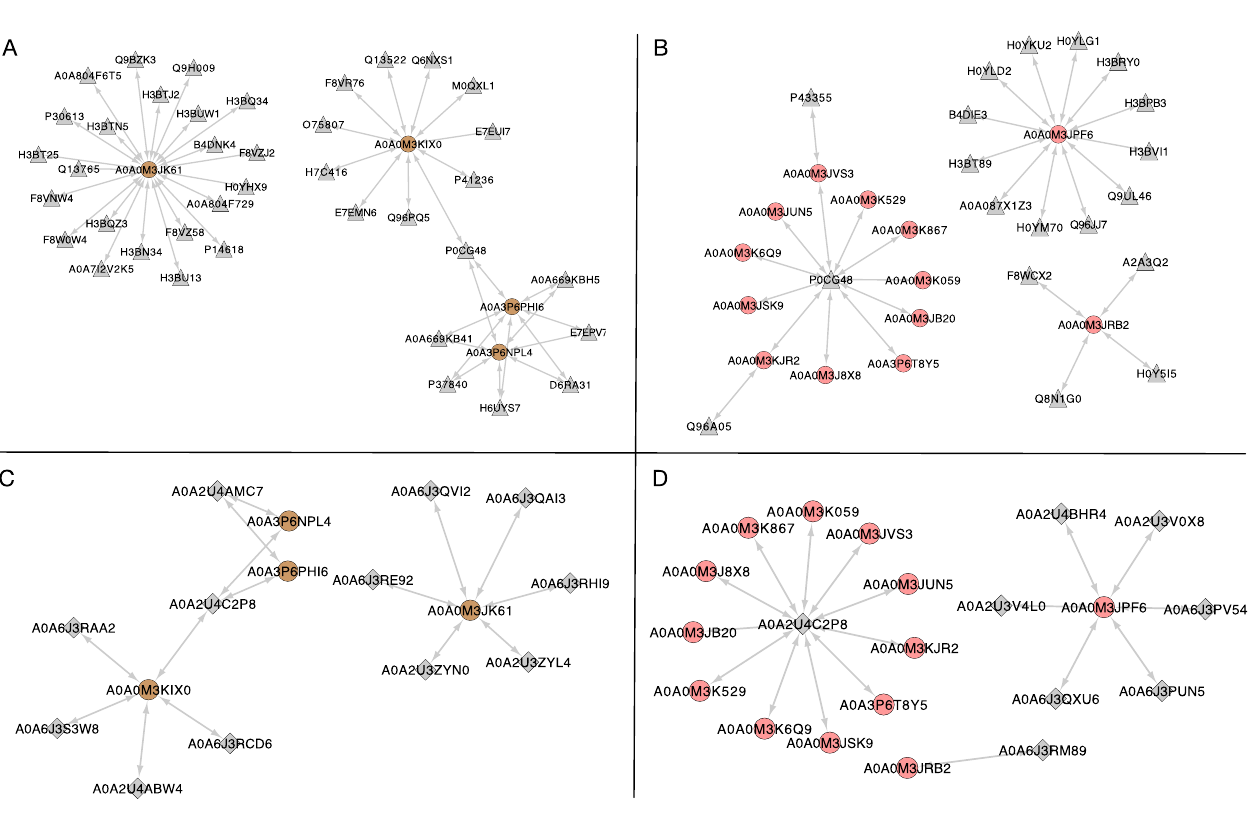
Figure 7. Host–parasite interactions between specific tissues of the L4 development stage of Anisakis simplex s. s. and selected hosts. Interactions with the human ( Homo sapiens ) proteome and proteins identified in the cuticle and intestine of A. simplex s. s. are presented in part ( A , B ), respectively. Interactions with the Atlantic bottlenose dolphin ( T. truncatus ) proteome and proteins identified in the cuticle and intestine of A. simplex s. s. are presented in part ( C , D ), respectively. Visualization was performed in Cytoscape v. 3.9.1. A detailed description of all proteins submitted to the analysis can be found in File S7.